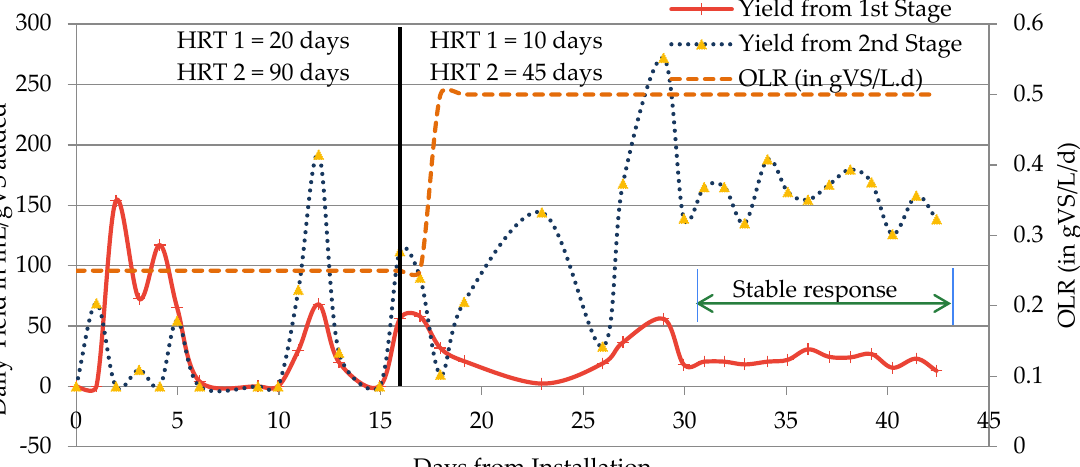
Figure 6. Record of daily biogas yields until a stable response from the operation of the TSAD system after the second stage restart.